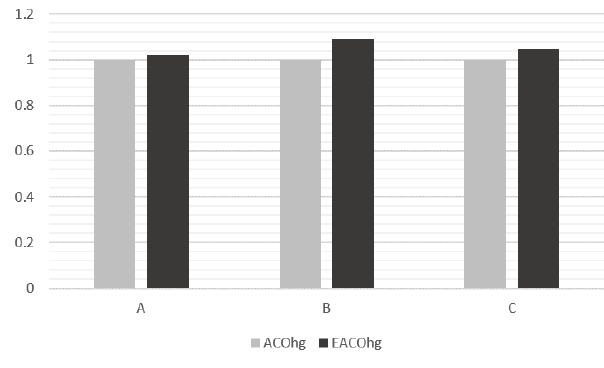
Figure 11. Memory